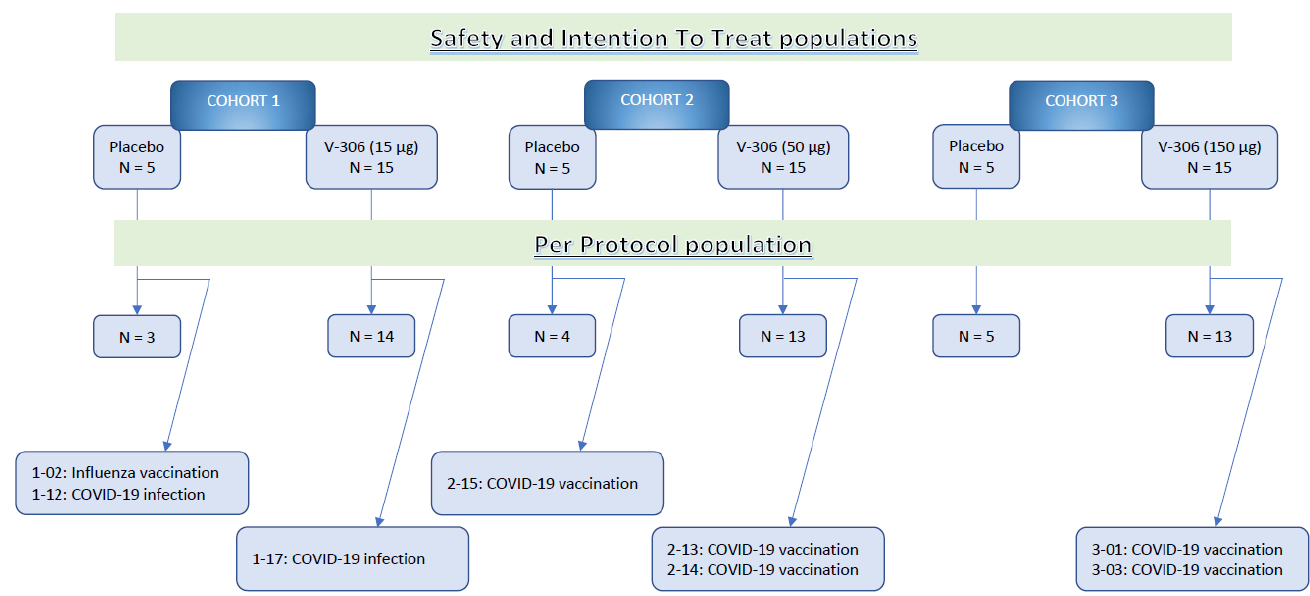
Figure 2. Study CONSORT diagram.